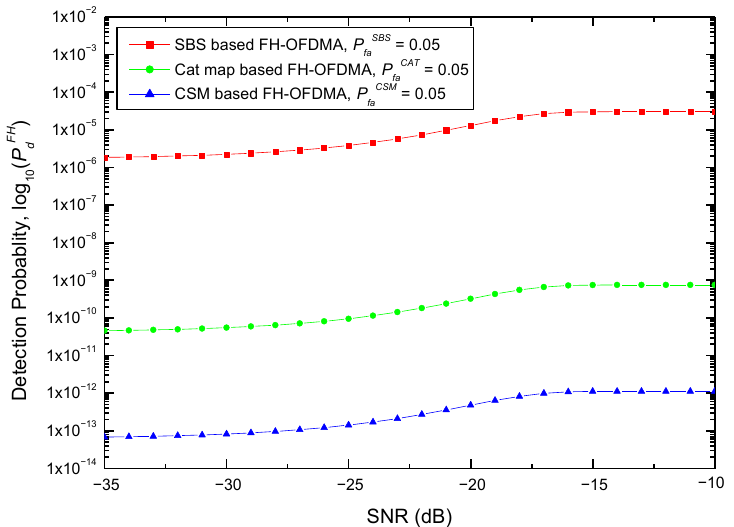
Figure 4. Detection probability versus SNR compared to SBS, cat map, and CSM-based FH-OFDMA